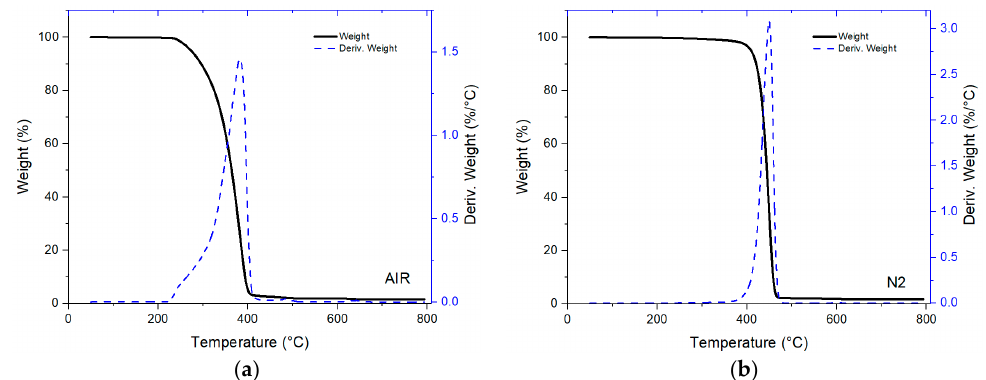
Figure 2. Thermal gravimetric analysis (TGA) thermograms of recycled PP in ( a ) air and ( b ) nitrogen